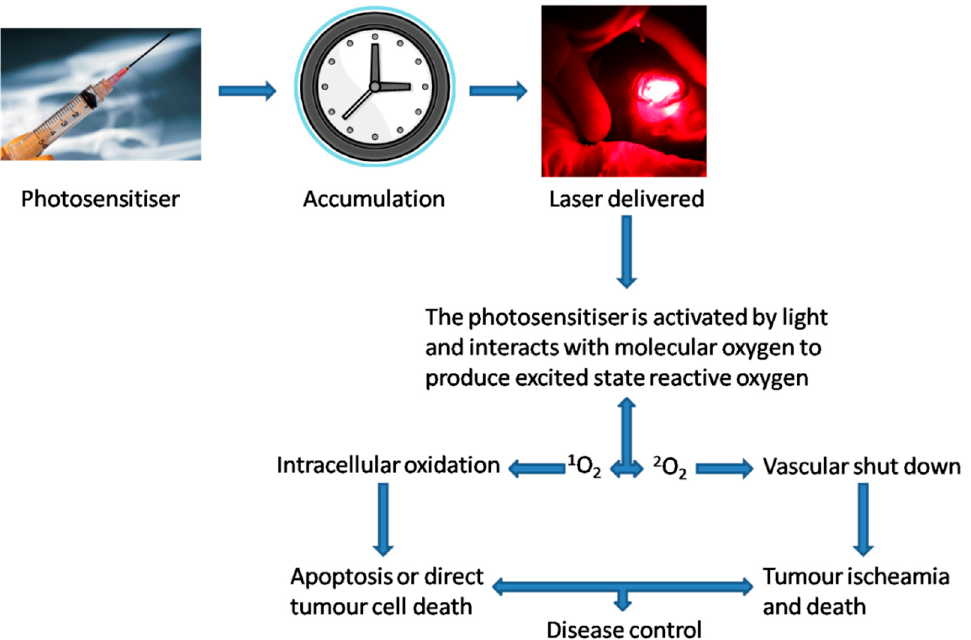
Figure 1. Theory behind the stages of photodynamic therapy application. Reprinted with permission from ref. [10]. Copyright 2010 Clin. Oncol. (R. Coll. Radiol.).